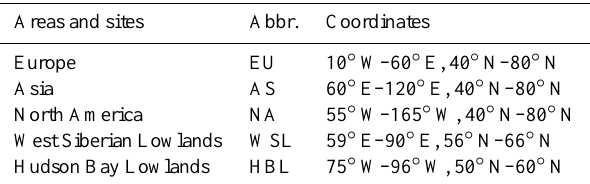
Table 3. List of areas and sites.